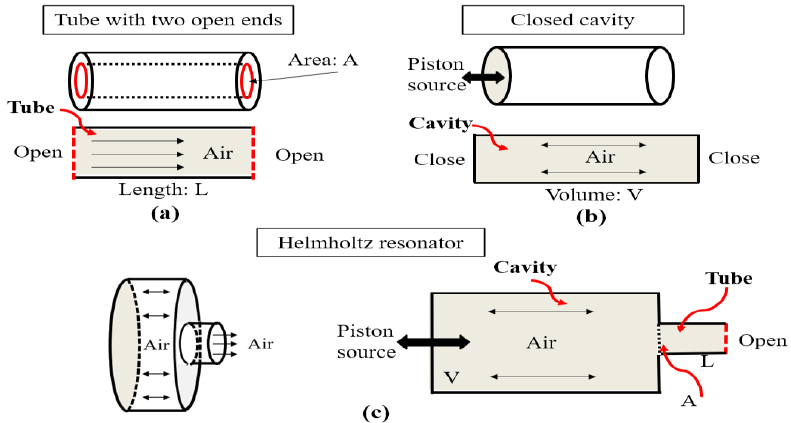
Figure 3. Acoustic modeling: ( a ) A tube with two open ends, ( b ) a closed cavity, and ( c ) a Helmholtz resonator.